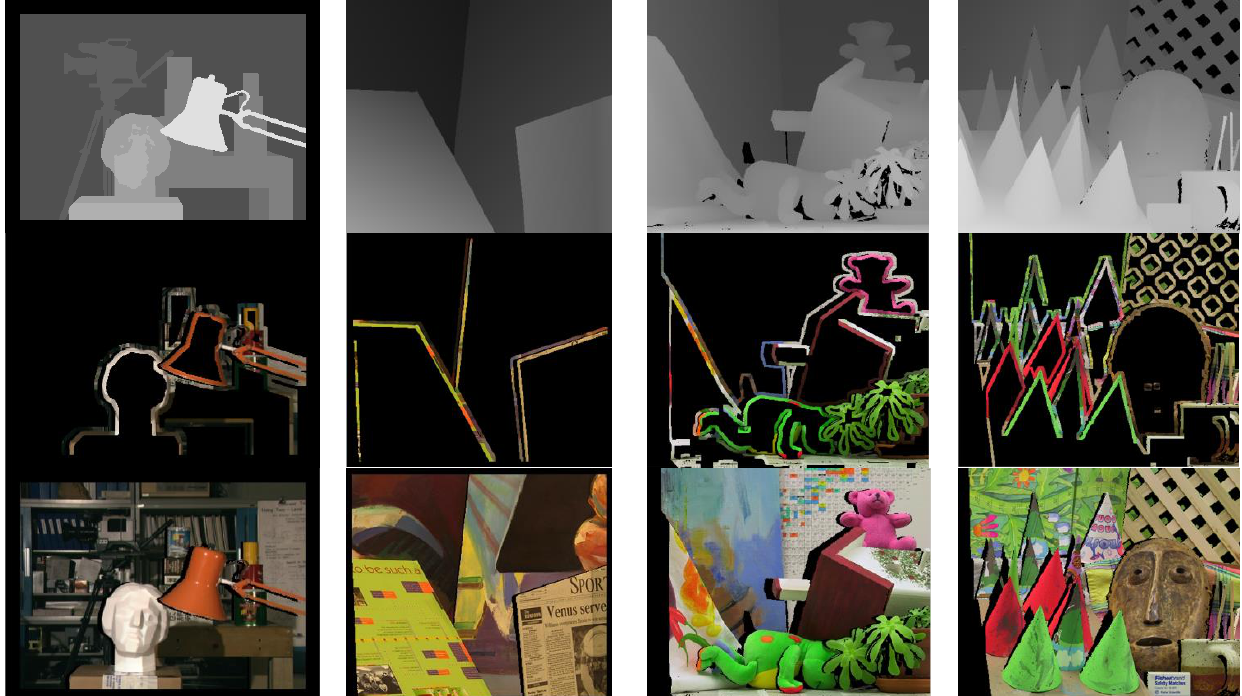
Figure 8. Ground truth, discontinuities, and continuities. Ground truth (first row), discontinuities (second row), continuities (third row). Method